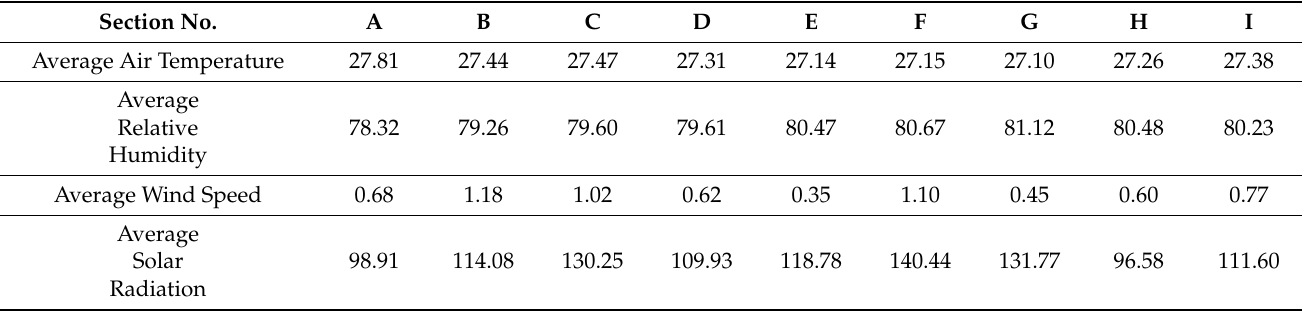
Table A3. The average air temperature ( ◦ C), the average relative humidity (%), the average wind speed (m/s), and the average solar radiation (W/m 2 ) of each section on 11 September and 12 September from 16:00 to 16:30.